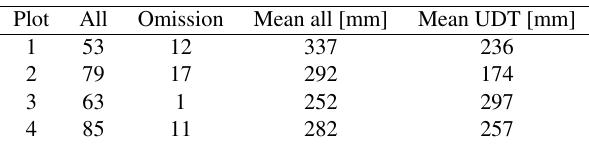
Table 2. Total number of trees (all), number of undetected trees (Omission), mean DBH for all trees (Mean all), and mean DBH for undetected trees (Mean